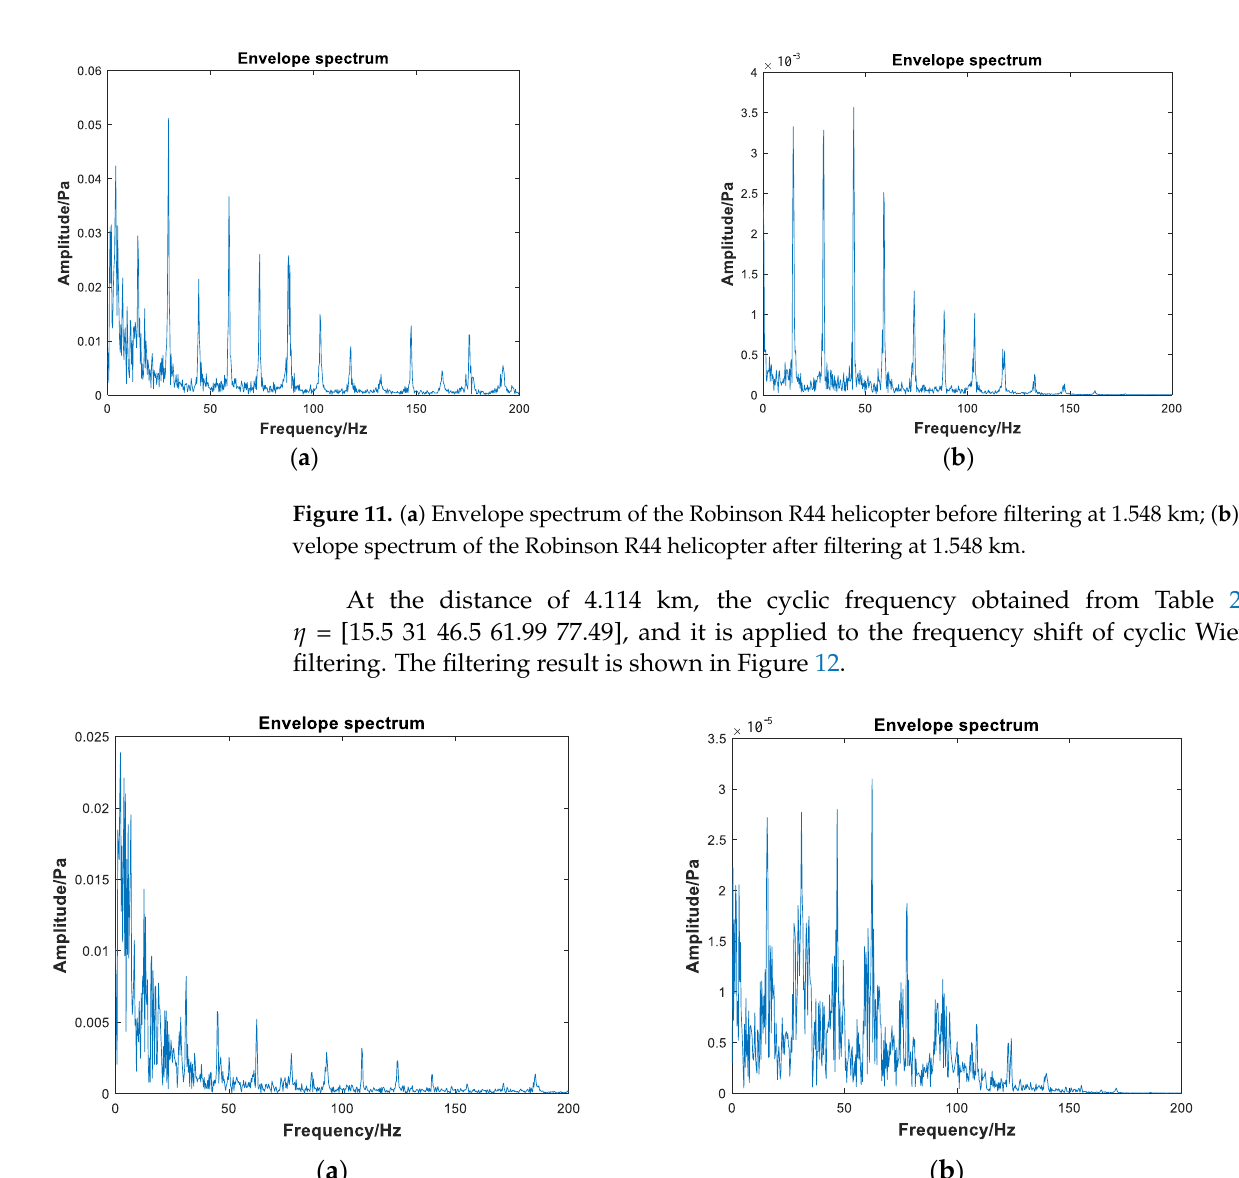
( b ) Figure 13. ( a ) Envelope spectrum of the Robinson R44 helicopter before filtering at 17.75 km; ( b ) Envelope spectrum of the Robinson R44 helicopter after filtering at 17.75 km.